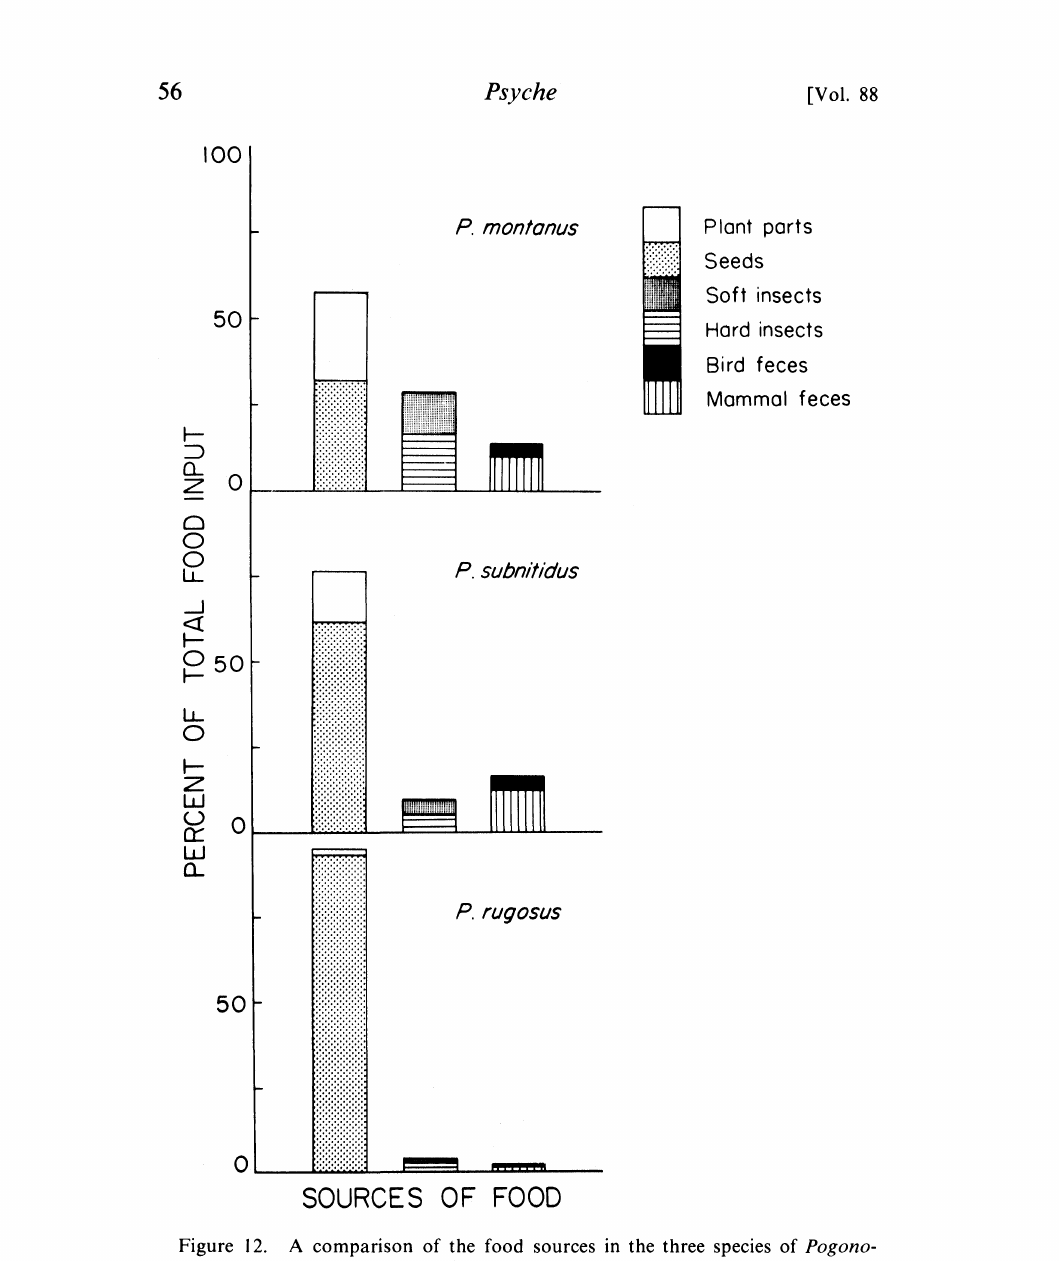
Figure 12. A comparison of the food sources in the three species of Pogono- myrmex harvester